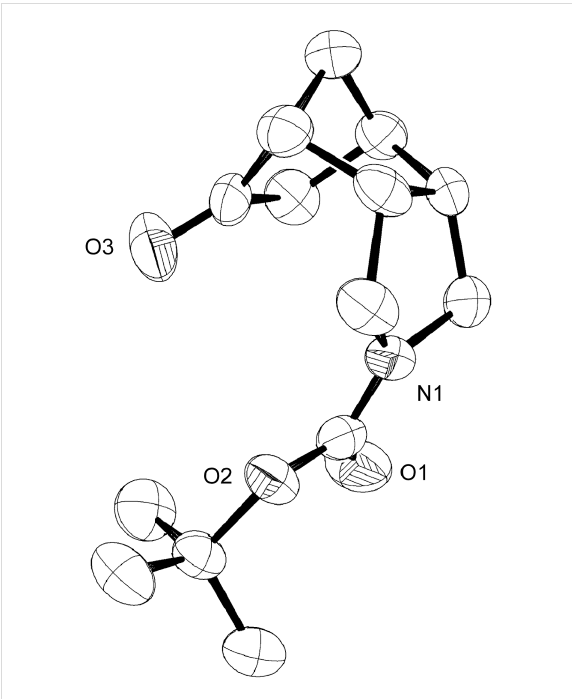
Figure 3: X-ray crystal structure of 9 . X-ray data have been deposited with the Cambridge Crystallographic Data Centre (CCDC 743050).